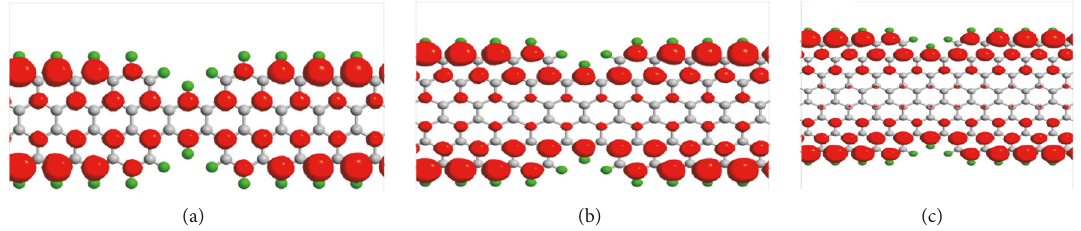
Figure 9: The isosurface of spatial electron distribution for the (a) 4-DZGNR, (b) 6-DZGNR, and (c) 8-DZGNR structures, respectively, at bias zero and Fermi energy